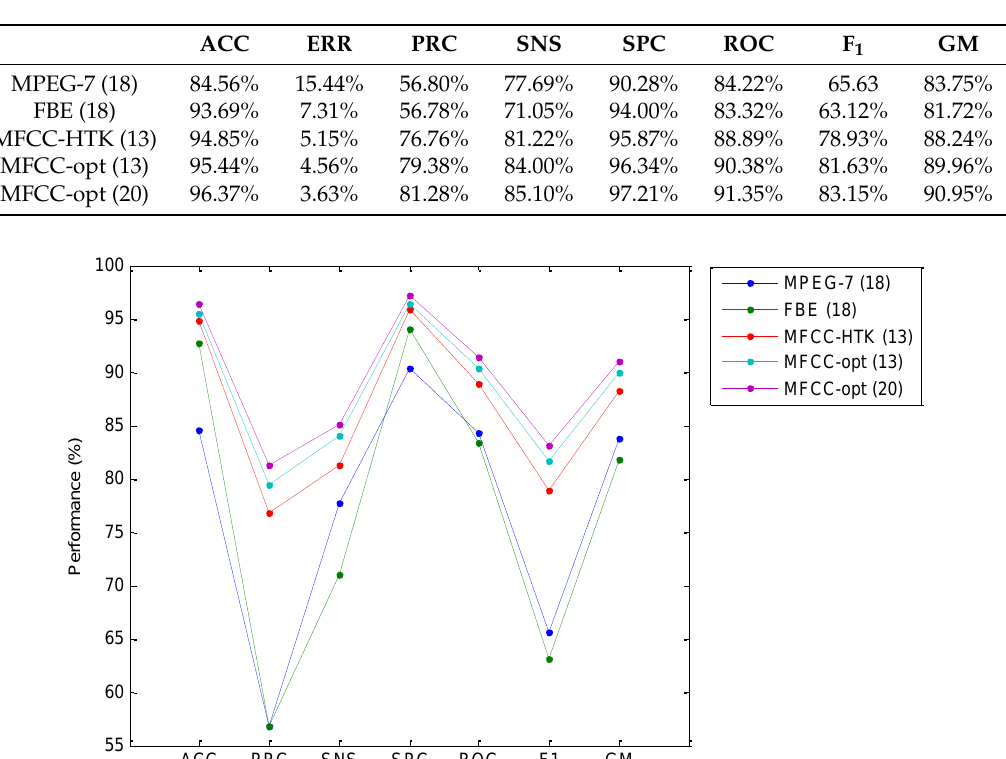
Table 10. Classification performance using different alternatives for the representation of the anuran call spectrum.